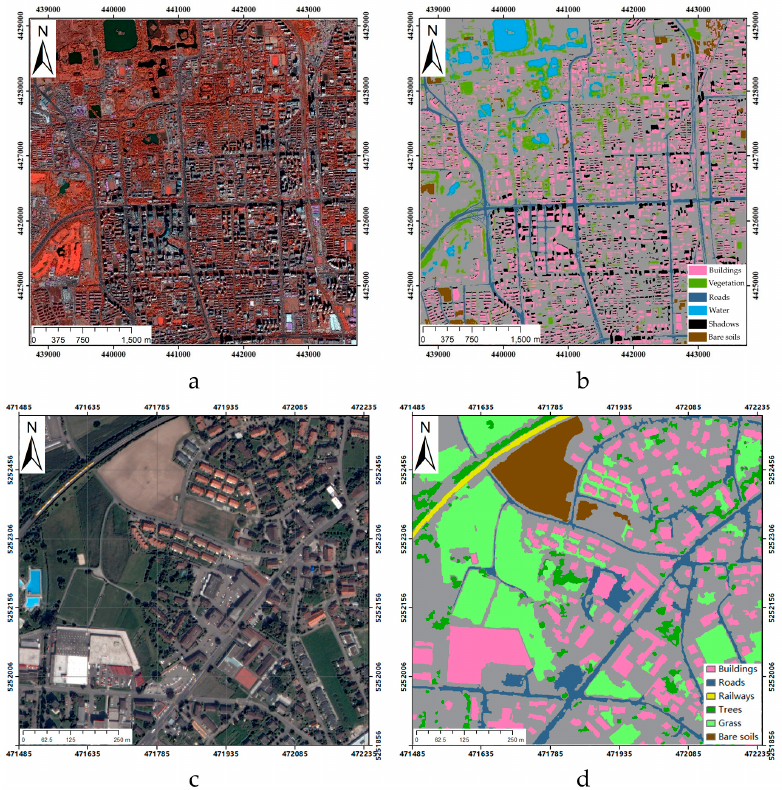
Figure 8. Study datasets. ( a ) Image of Beijing dataset, ( b ) reference map of Beijing dataset, ( c ) image of Zurich dataset, and ( d ) reference map of Zurich dataset.